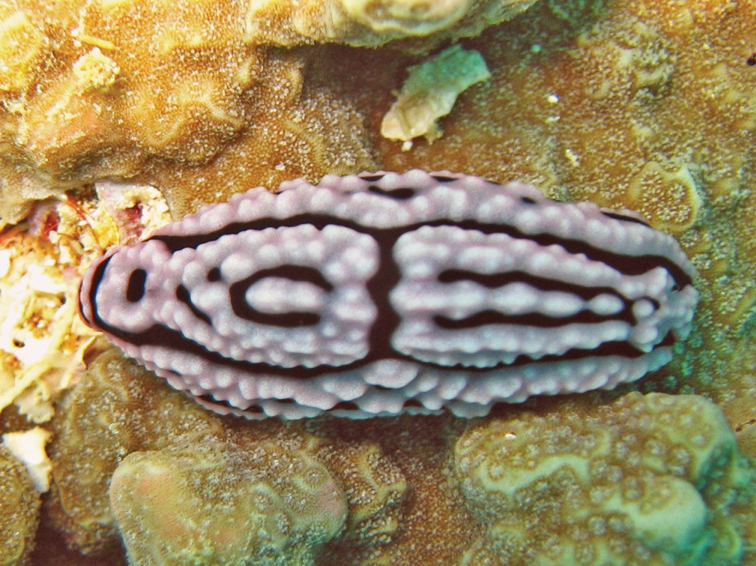
Phyllidiella meandrina, Tanzania, photo: A de Villiers (no spcm).